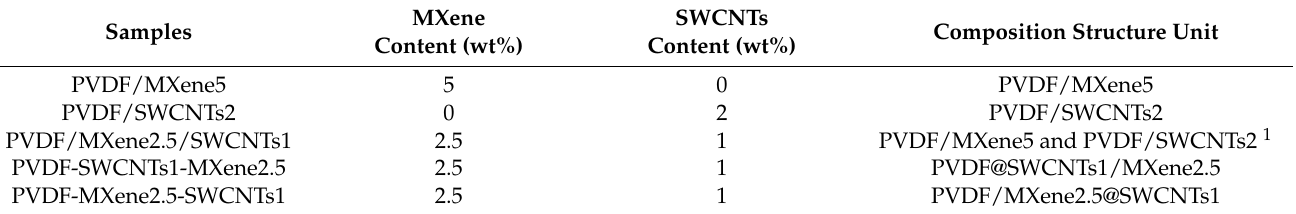
Table 1. Weight by percent composition of the MXene/SWCNTs composite.